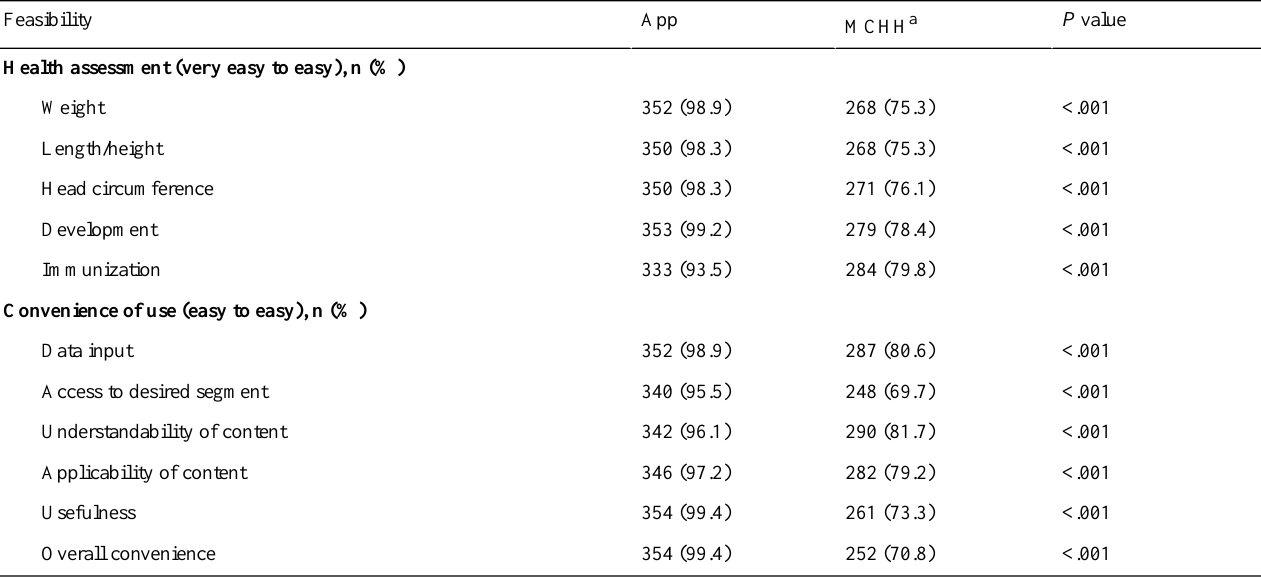
Table 5. Parents’ratings of feasibility: health assessment and convenience of use of mobile app versus maternal and child health handbook